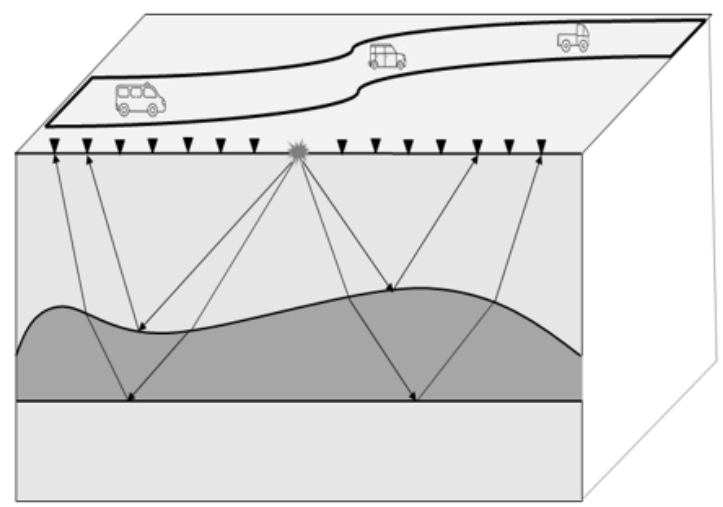
Figure 1. The land acquisition scenario of road